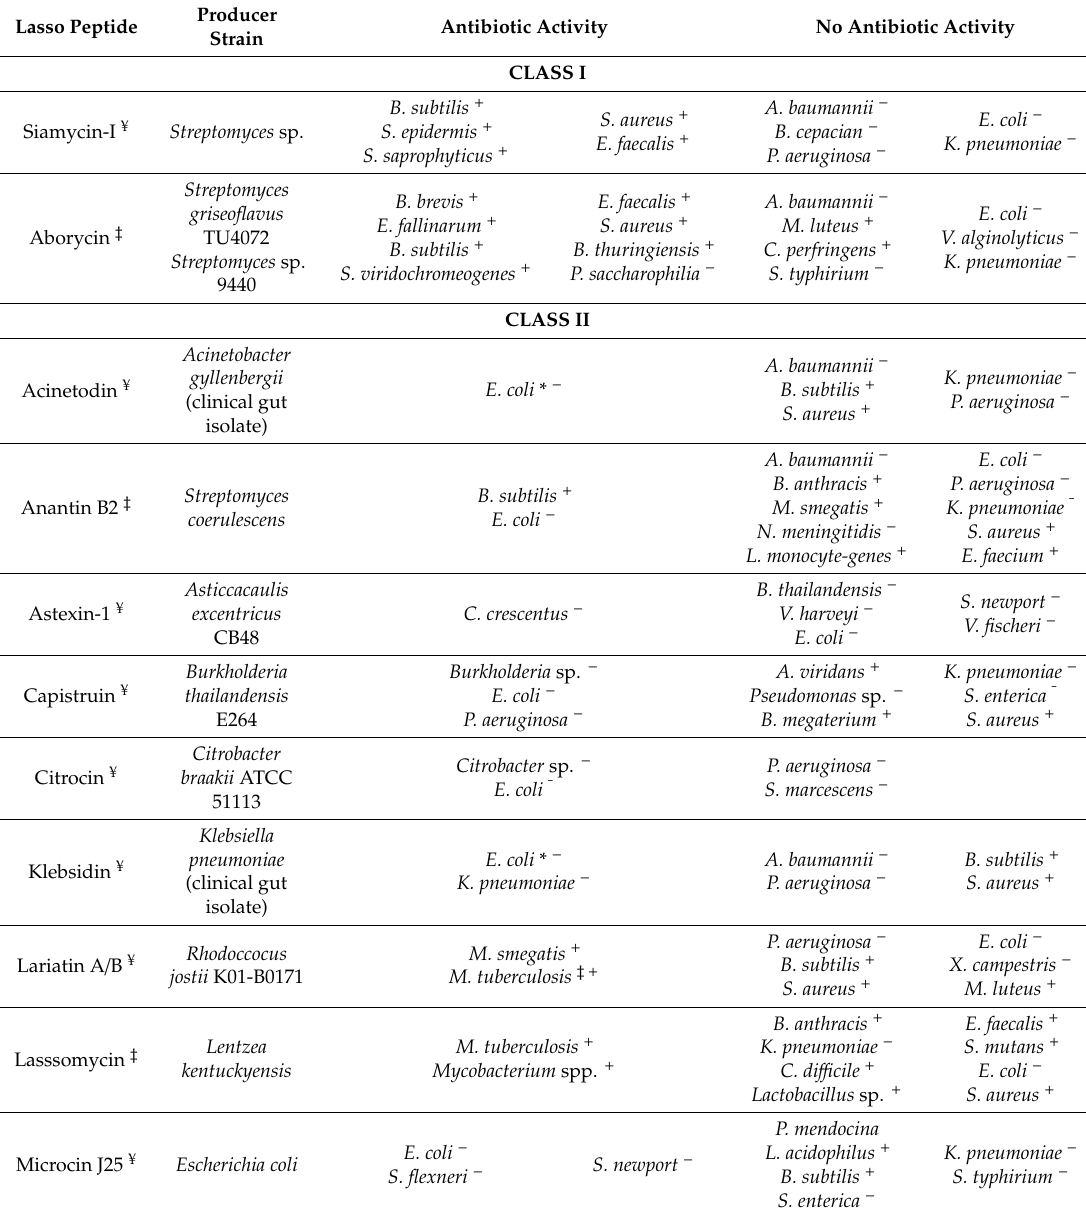
Table 1. Antibiotic activity of lasso